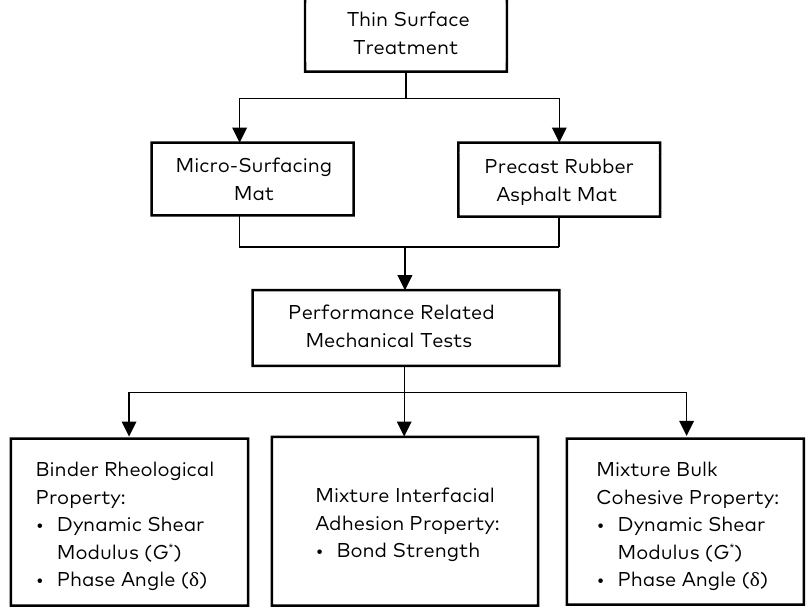
Figure 1. Experimental